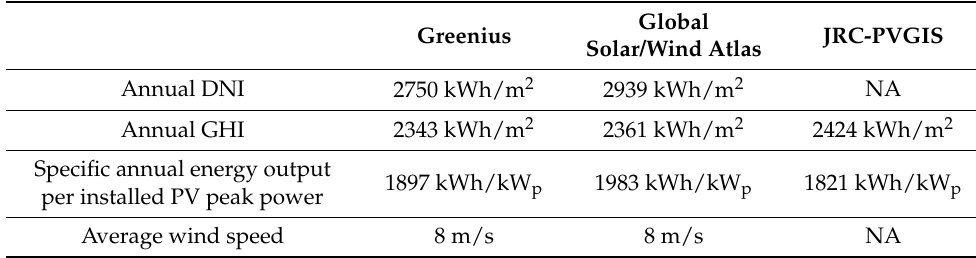
Table 1. Comparison of the annual base cases simulated with the weather data from Learmonth Airport [18] with web databases from energydata.info [19,20] and PVGIS